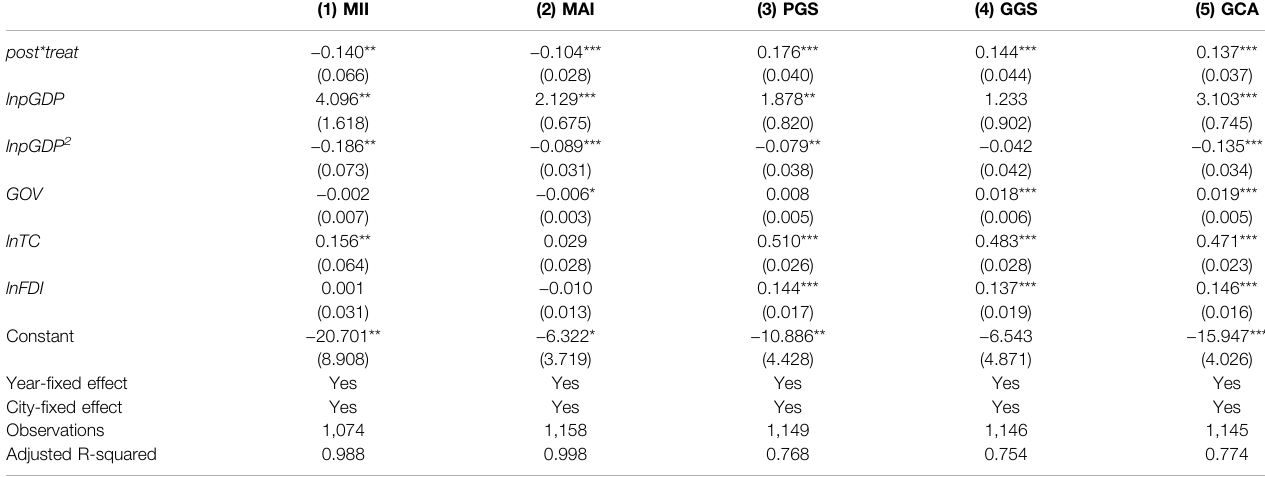
TABLE 3 | Mechanism tests.